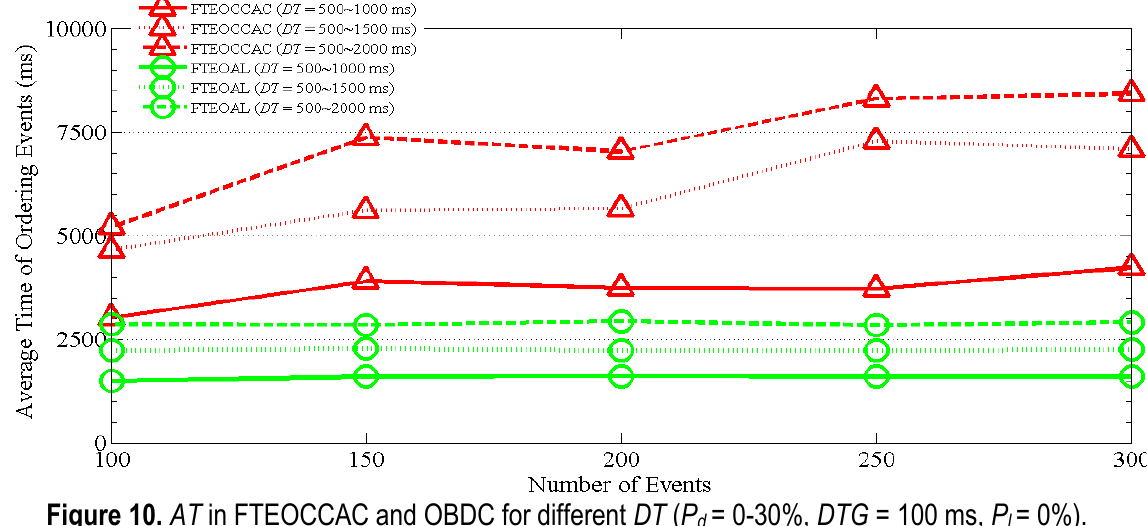
Figure 10. AT in FTEOCCAC and OBDC for different DT ( P d = 0-30%, DTG = 100 ms, P l = 0%).